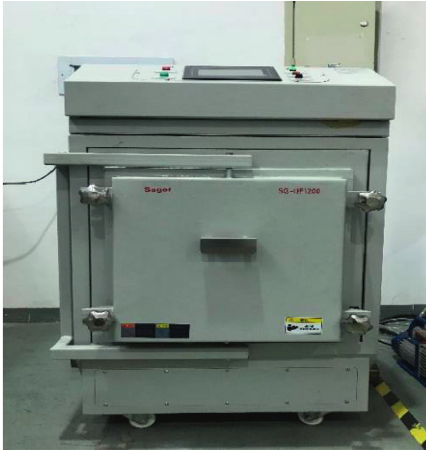
Figure 5: Box-type atmosphere